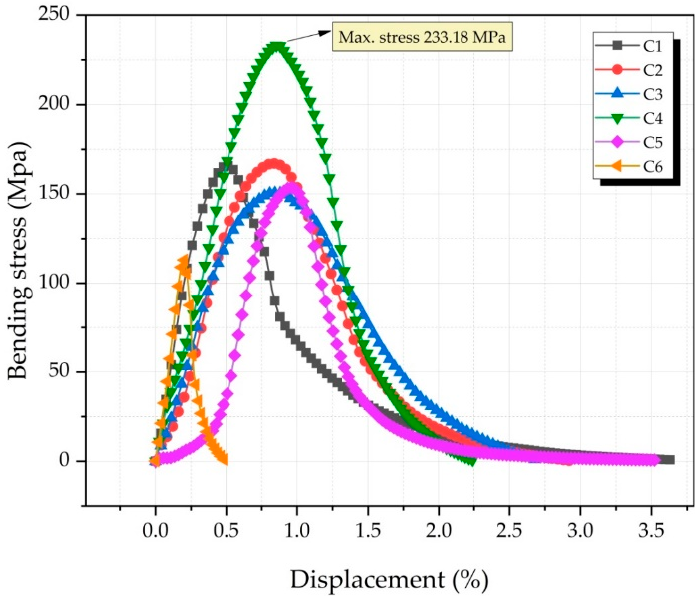
Figure 10. Three-point bending analysis graph of composites.